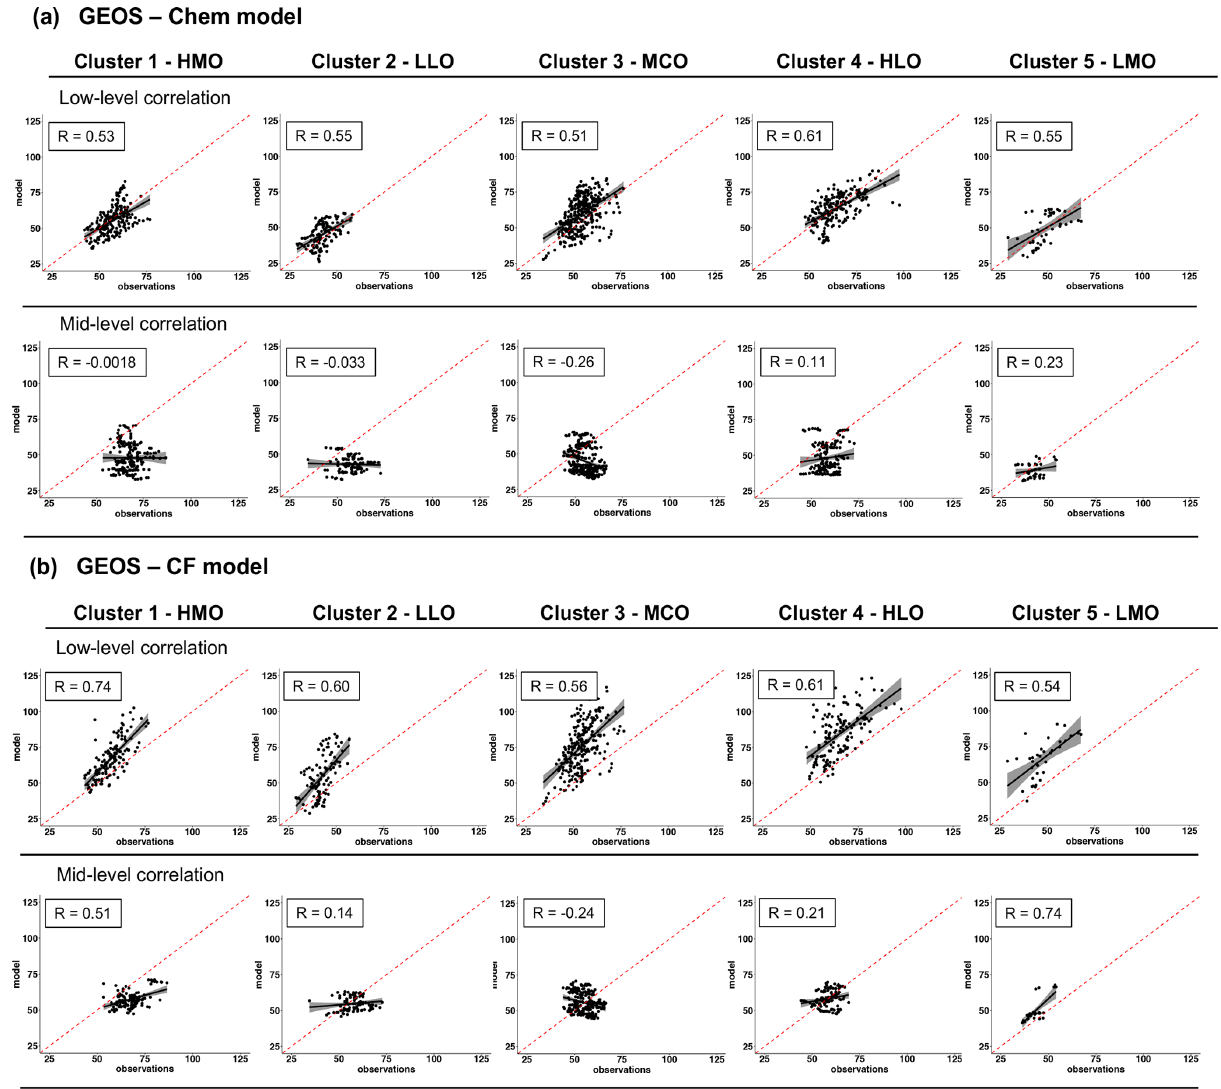
Figure 7. O 3 correlation between lidar observations and (a) GEOS-Chem model simulation results and (b) GEOS-CF model results by each cluster split by low level (top rows) and mid-level (bottom